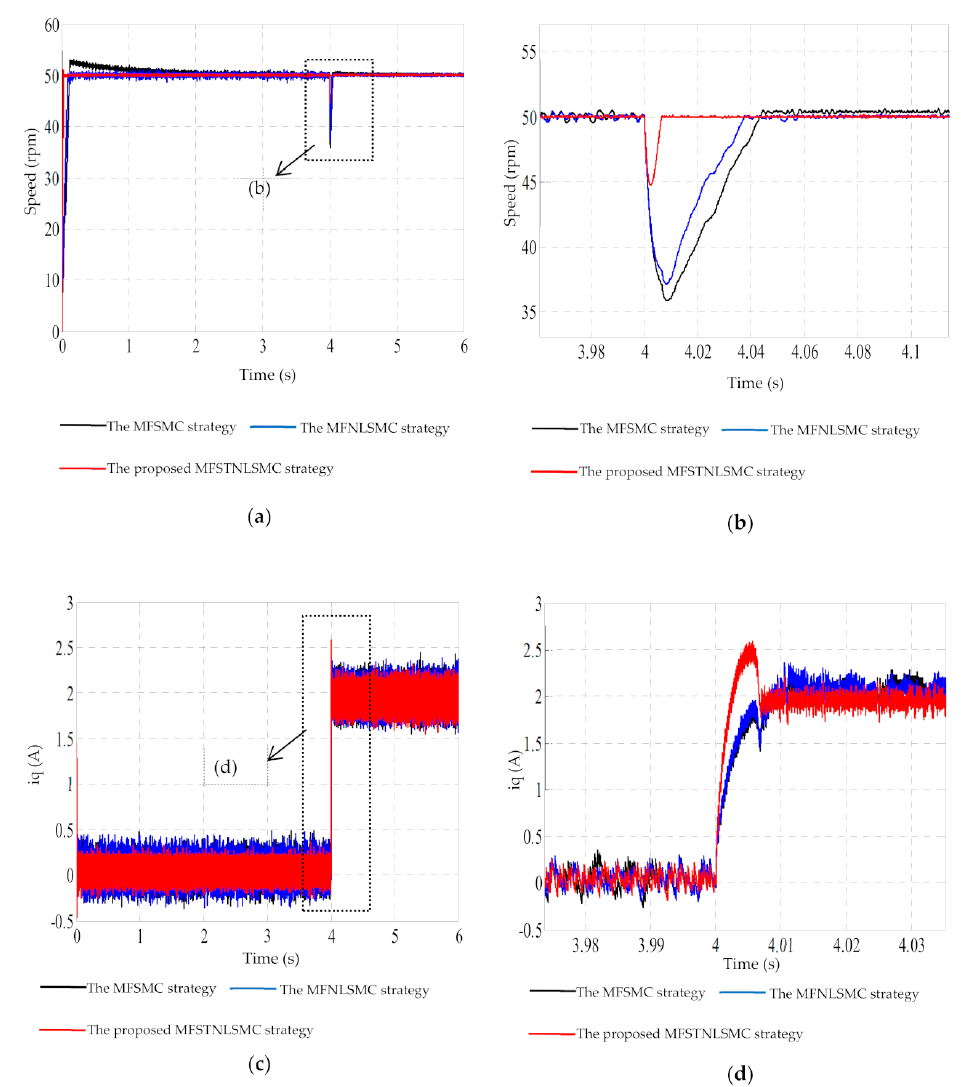
Figure 6. ( a ) Speed response curves rejecting external disturbance; ( b ) Detailed view of the image ( a ); ( c ) Circuit response curves of q axis; ( d ) Detailed view of the image ( c ).